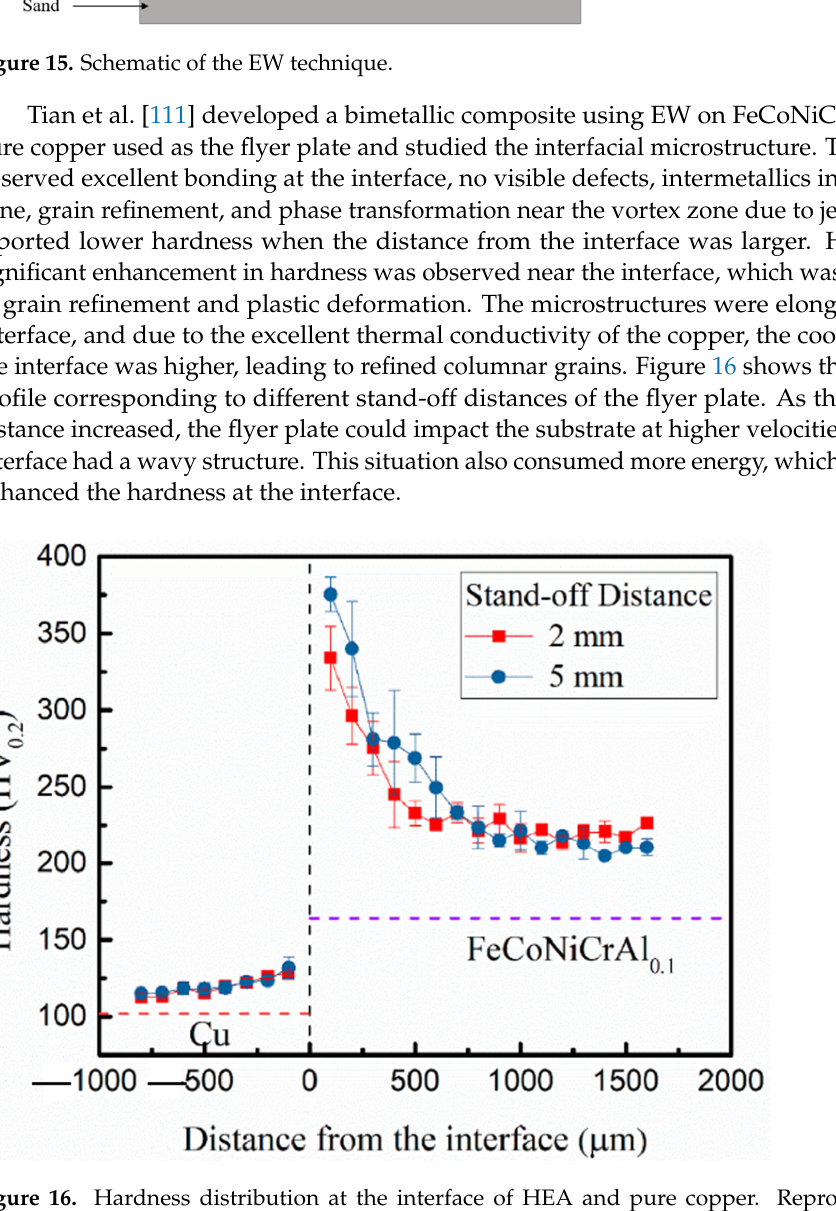
Figure 16. Hardness distribution at the interface of HEA and pure copper. Reproduced with per- mission from [111]. Copyright MDPI, 2021. Arab et al. [112] welded HEA and Al-6061 using three different stand-off distances, 1, 2, and 3 mm, so that the flyers struck the substrate with three different velocities. The authors revealed that the aluminum alloy and HEA were properly welded together in all cases. They observed a straight interface without any cracks after using 1 mm stand-off distance. However, they observed cracks after using 2 and 3 mm stand-off distances. The observed crack initiation site was the interface, and from there, it propagated throughout the HEA, and the cracks were due to the formation of intermetallic compounds during the welding process. The authors also reported an improvement in hardness in the alumi- num flyer, which was attributed to grain refinement and plastic deformation. Figure 17 shows the SEM of the EW of HEA and aluminum alloy. In the figure, the cracks can be easily seen. As mentioned previously, transverse cracks were observed after using 3 and 2 mm stand-off distances only, as represented in Figure 17a,b. This was attributed to the high impact energy associated with 3 and 2 mm stand-off distances. A shock wave was generated in the interface during EW with the aluminum flyer, causing it to propagate throughout the HEA and reach the free surface of HEA, leading to transverse cracking due to high impact energy.